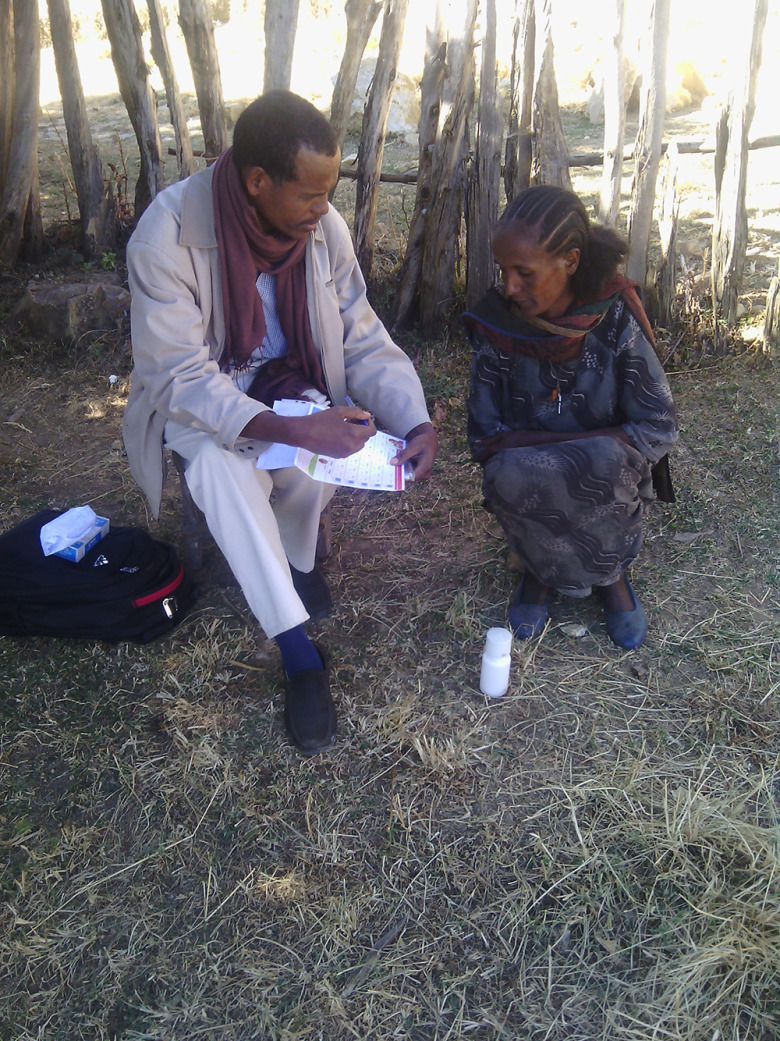
A trained interviewer conducting an interview with a pregnant woman about calcium supplementation acceptability and adherence. © 2015 Zewdie Birhanu/Jimma University.